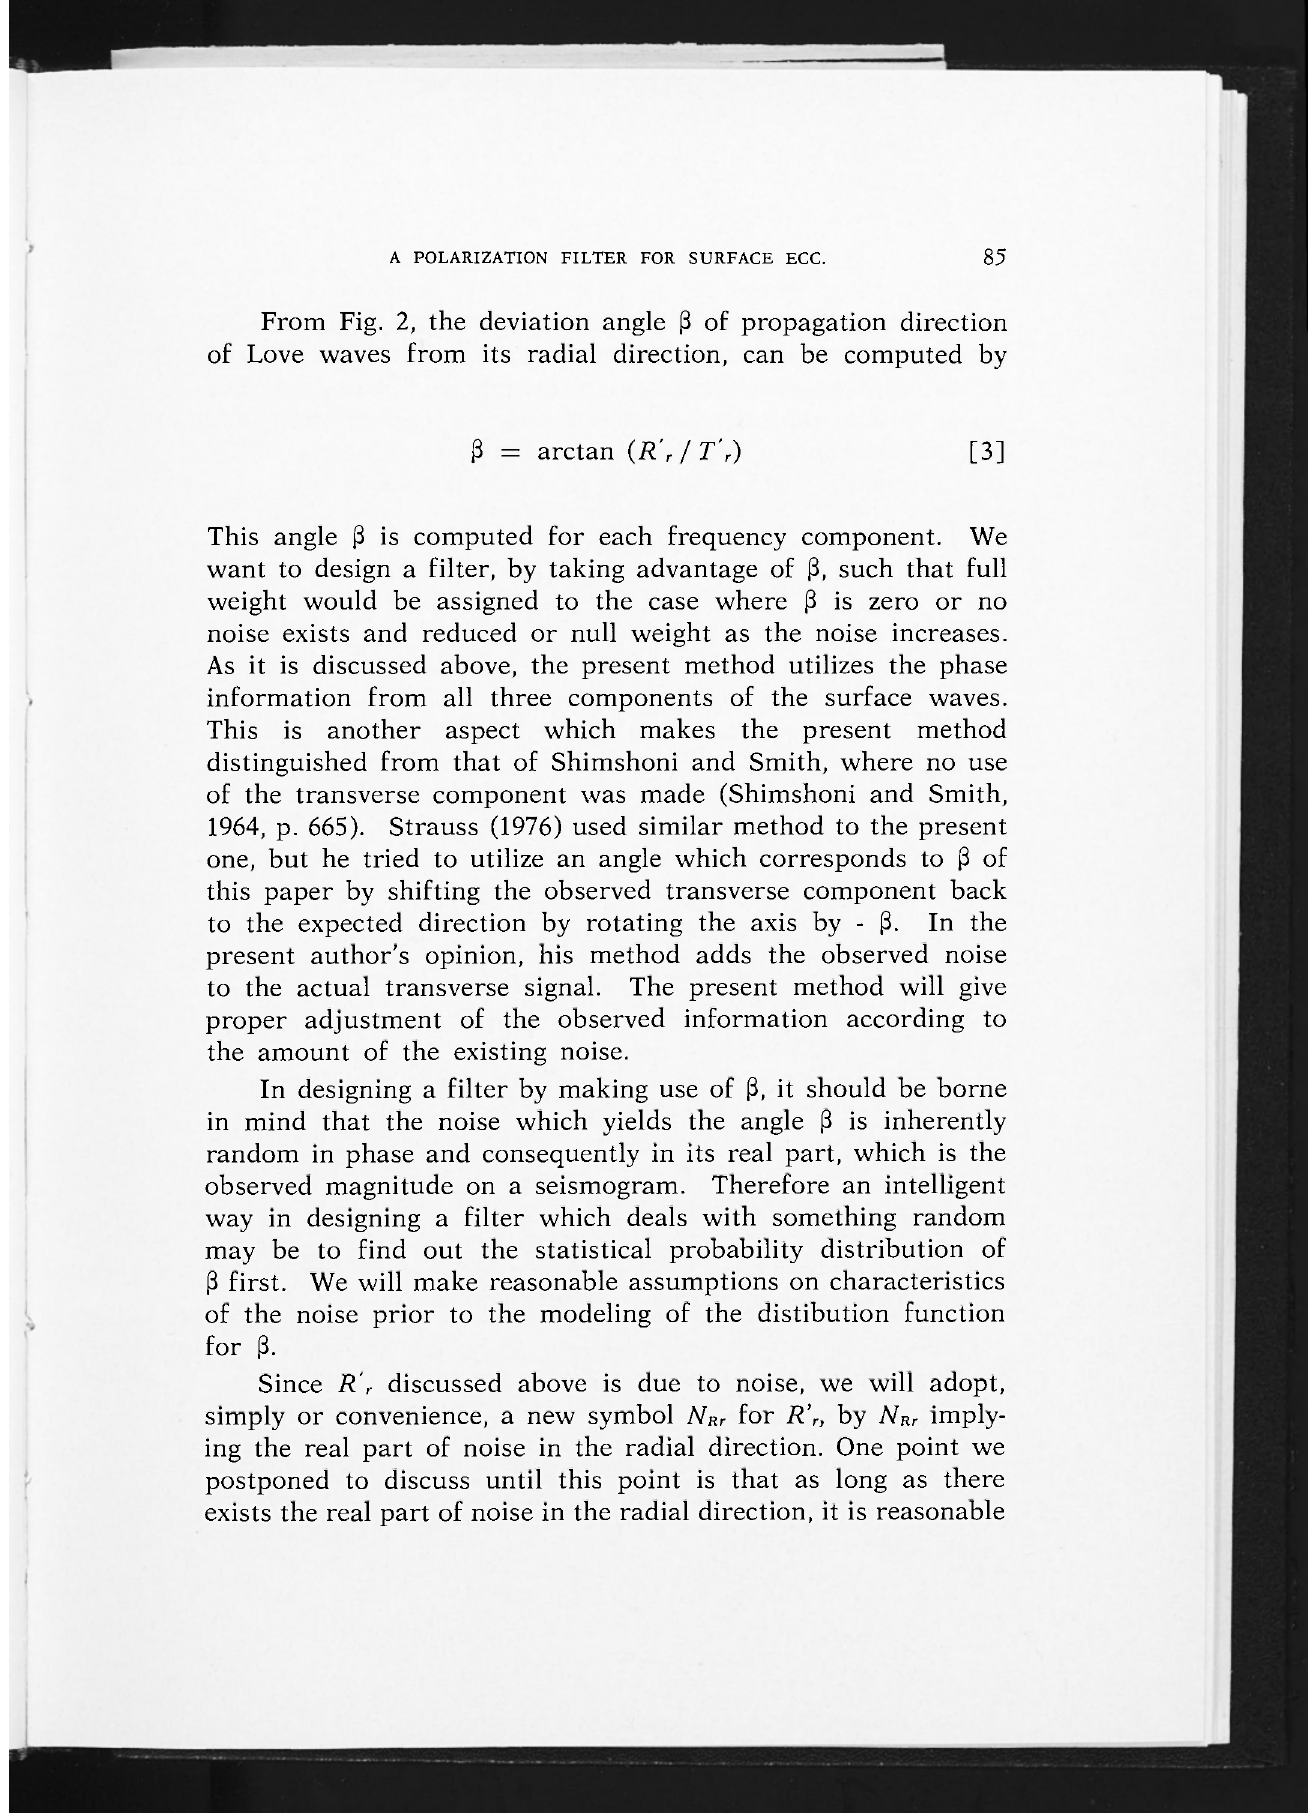
From Fig. 2, the deviation angle 3 of propagation